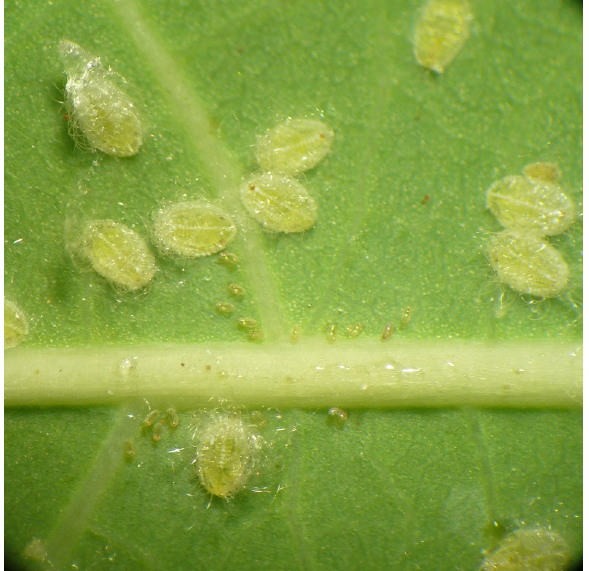
Figura 1. Ninfas de Aleurothrixus aepim